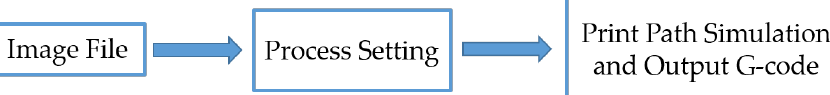
Figure 6. Slicing flowchart by Simplify 3D.